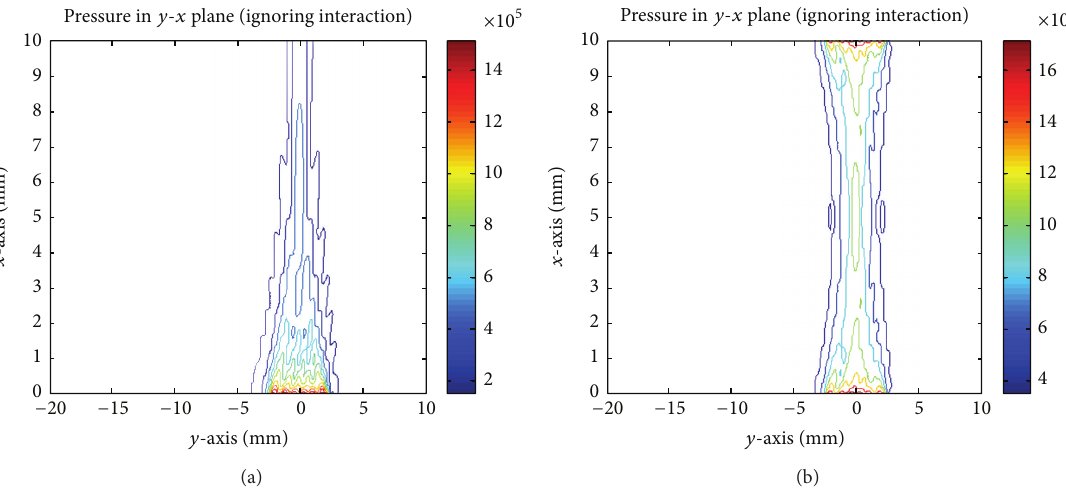
Figure 12: Acoustic pressure in the x-y plane in different interaction effects. (a) Acoustic pressure in the 𝑥 - 𝑧 plane for steering angle 0. (b) Acoustic pressure in the 𝑥 - 𝑧 plane when the interaction effect is considered.